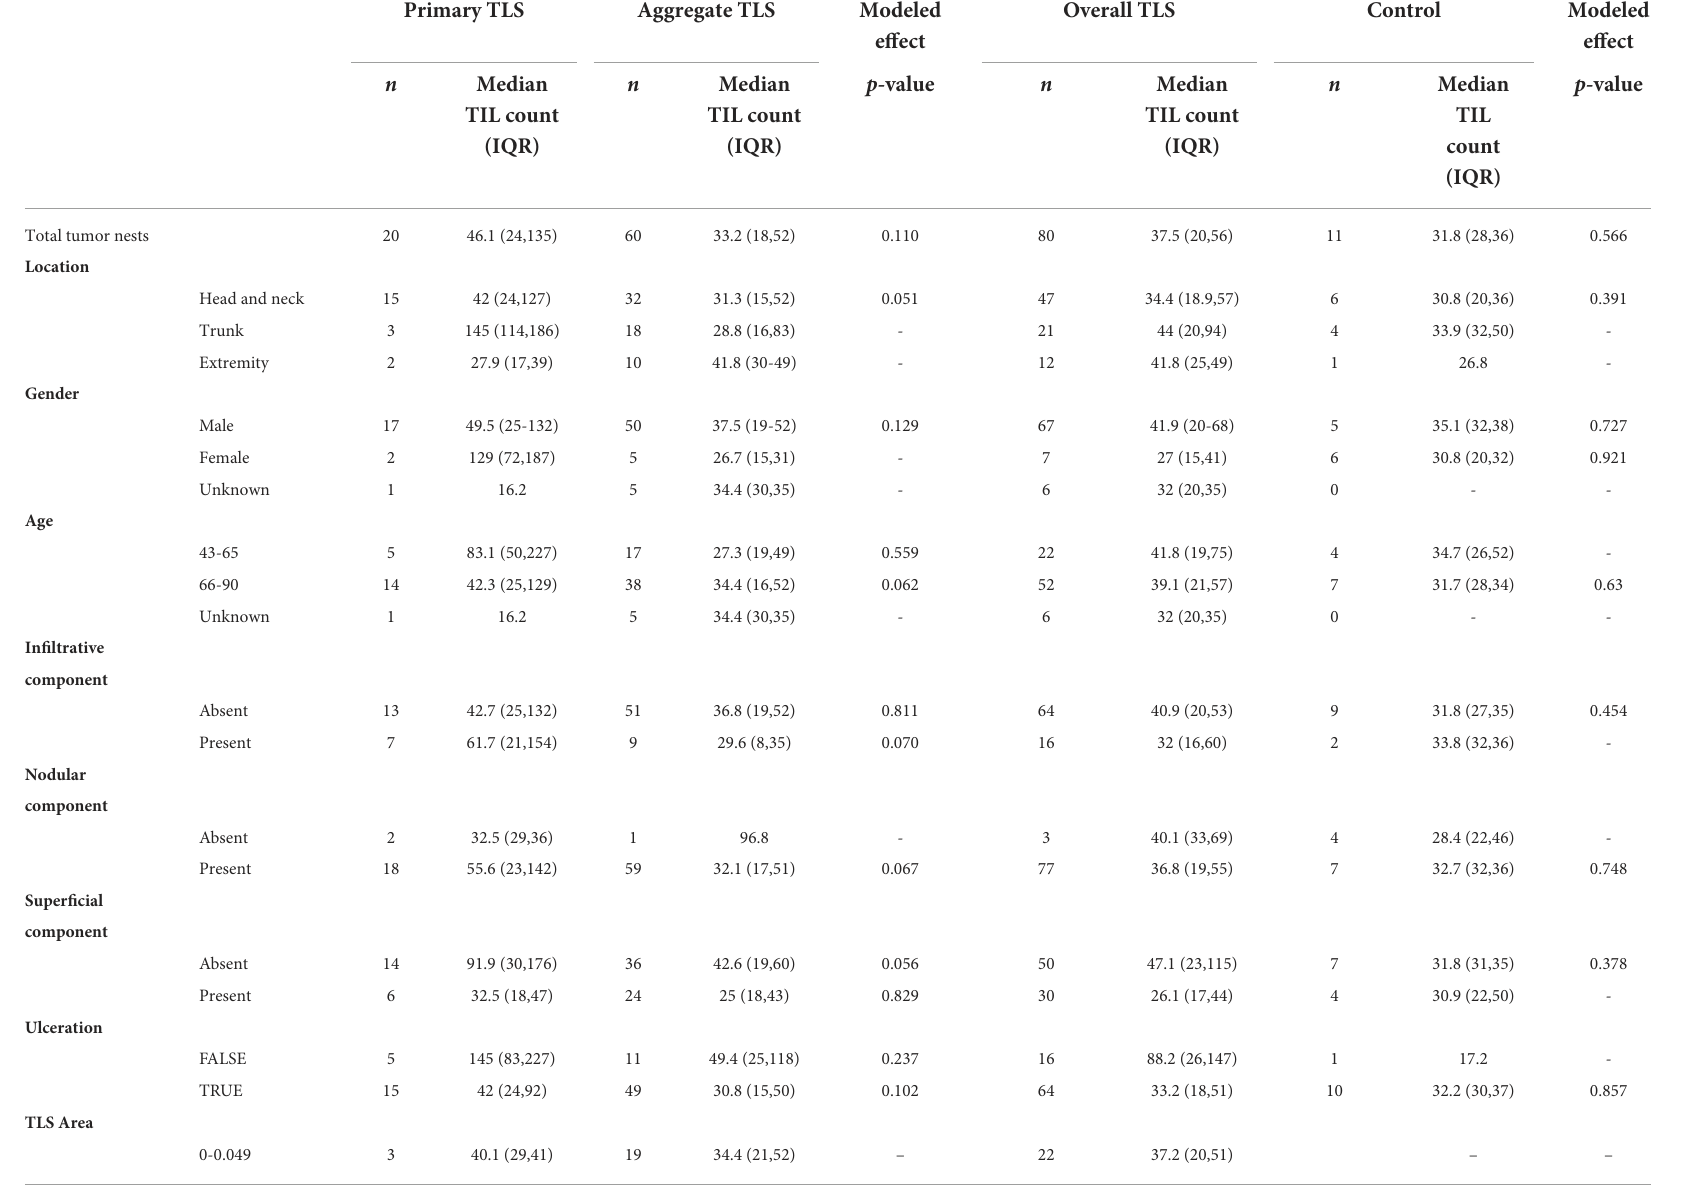
TABLE 4 Effect of TLS properties on TIL count ( n represents tumor nests either proximal to shared TLS or without TLS in control